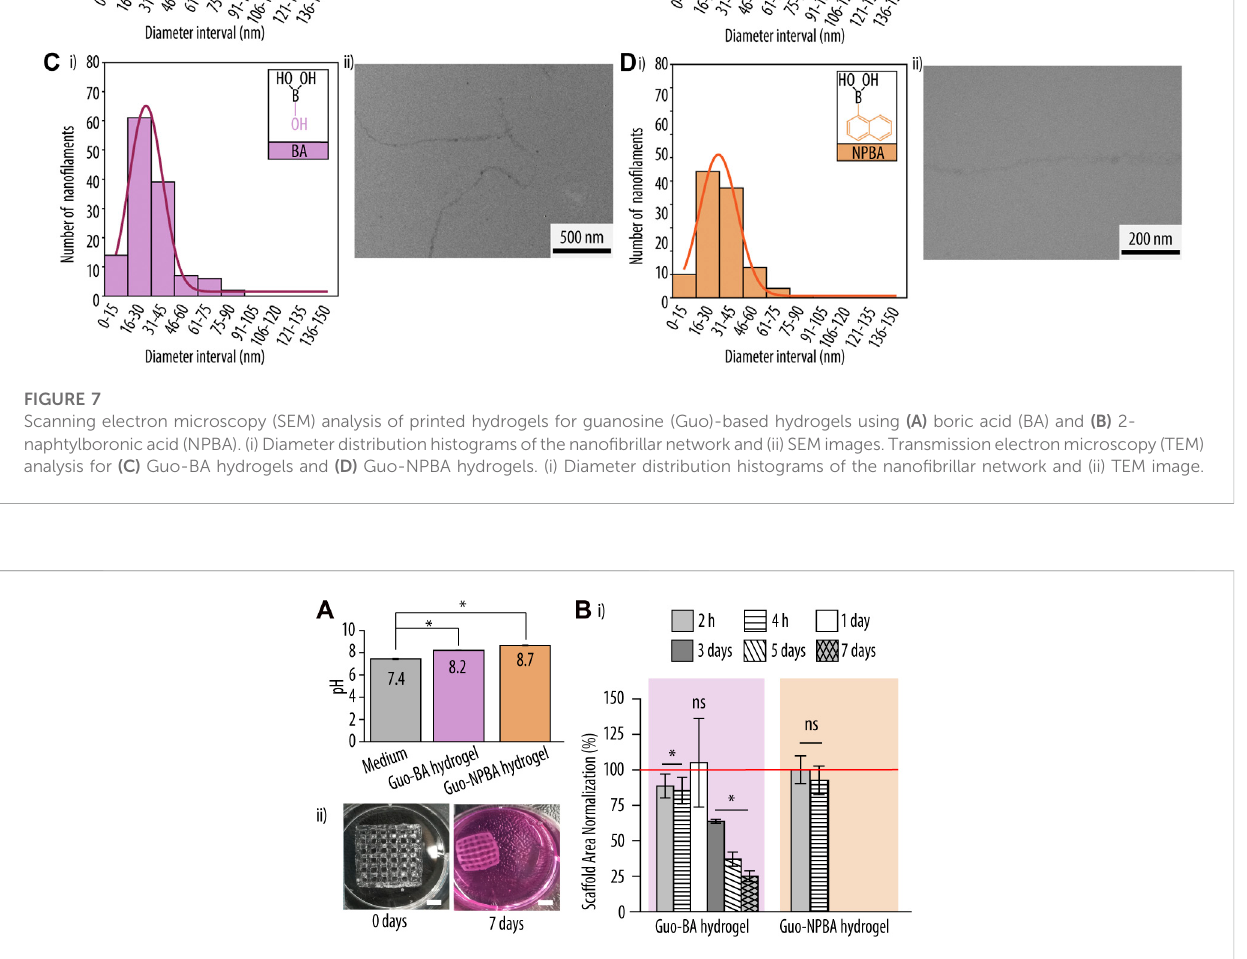
FIGURE 8 Biocompatibilityevaluationoftheprintedhydrogelscaffolds. (A) pHvaluesoftheprintedguanosine(Guo)-basedhydrogelsusingboricacid(BA)and 2-naphtylboronic acid (NPBA) hydrogels vs. complete McCoy 5A medium. (B) (i) Normalized scaffold areas of printed Guo-BA and Guo-NPBA hydrogels after incubation in McCoy 5A medium at 37 ° C for up to 7 days. The red line represents 100% viability of the cells at 0 h (control). Difference testing